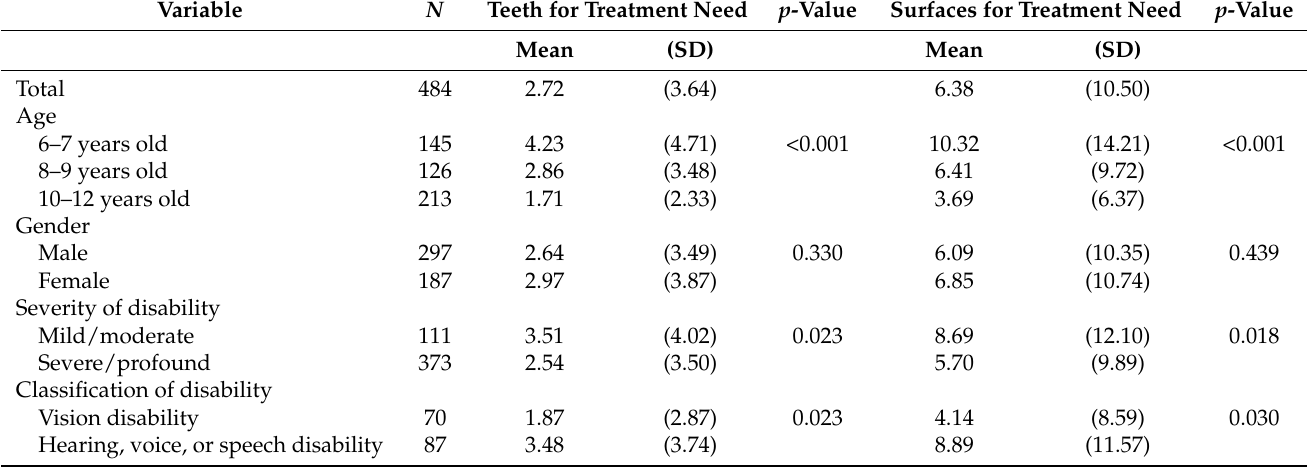
Table 1. Dental treatment needs of teeth and surfaces by demographics and dietary and tooth-brushing habits among children with